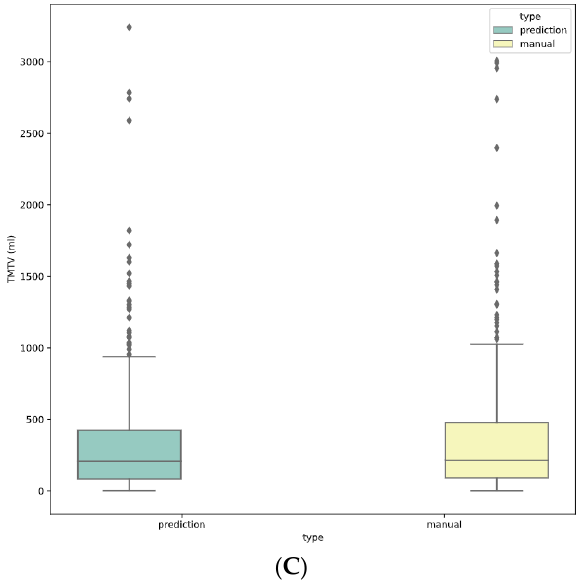
Figure 1. Boxplot of TMTV distribution for predicted and manual TMTV for each methodology ( A ) 41%, ( B ) 2.5, ( C ) 4.0.